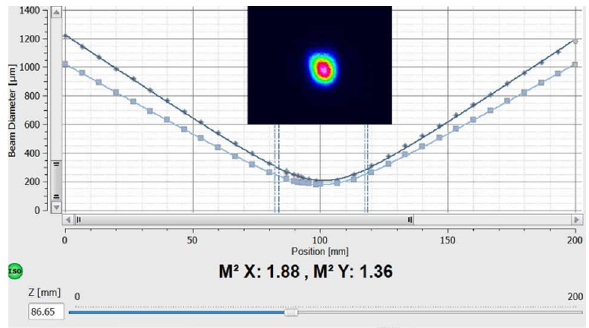
Fig.4. The result of the beam quality measurement at 100 W output average power at 20 MHz 1, with the beam profile